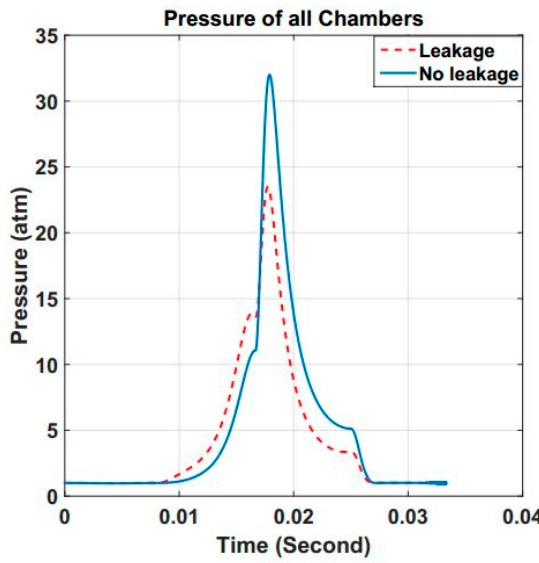
Figure 9. Pressure of working fluid vs. time over one cycle (30 Hz).